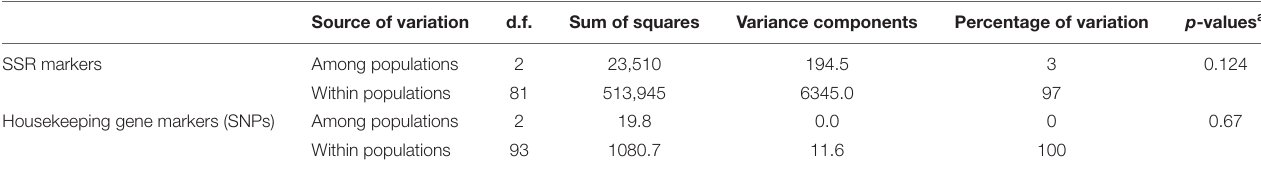
TABLE 4 | Analysis of Molecular Variance (AMOVA) for the three Zymoseptoria tritici populations using SSR markers and housekeeping gene